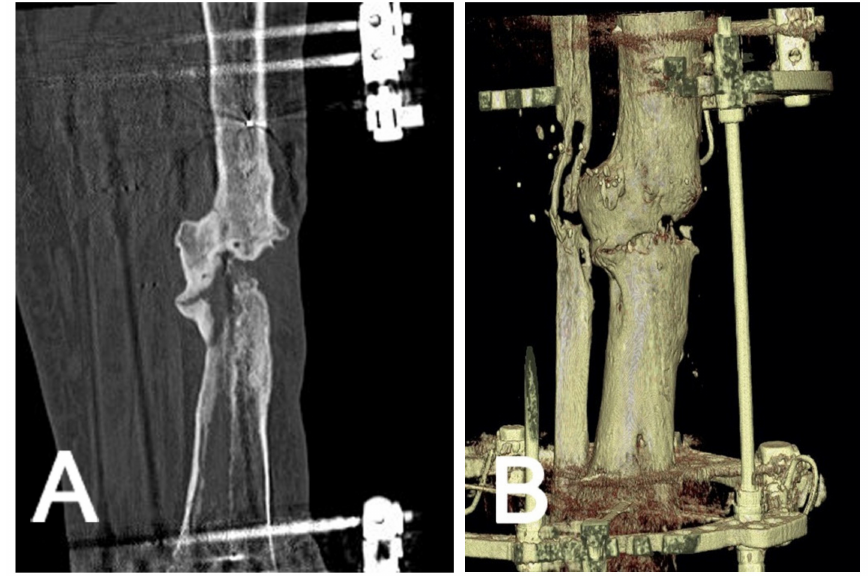
Figure 2. Non-union evaluation in a tibial bone with a 2D ( A ) and 3D view ( B